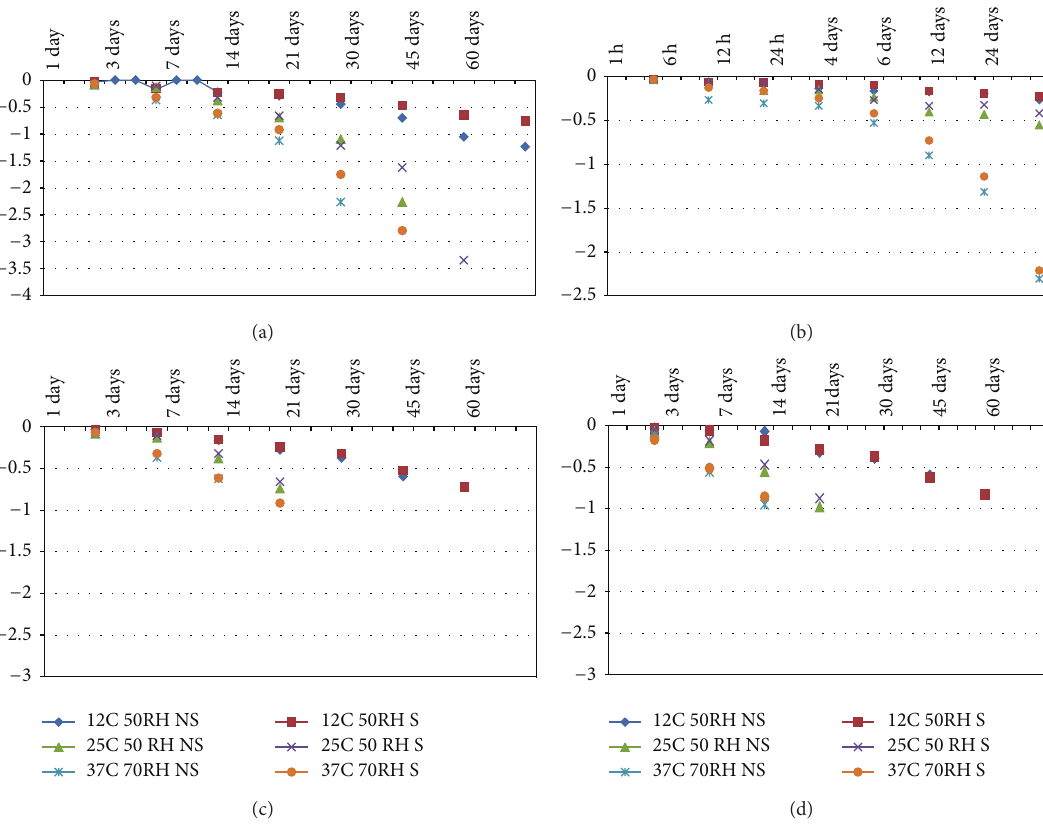
For Cryptosporidium oocysts, kept in water, soils, and